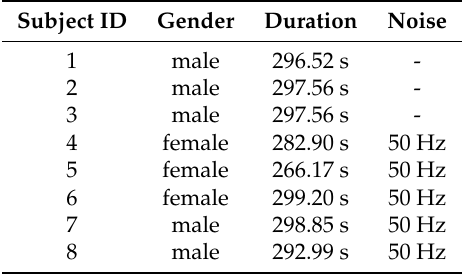
Table 1. Recordings used for the present